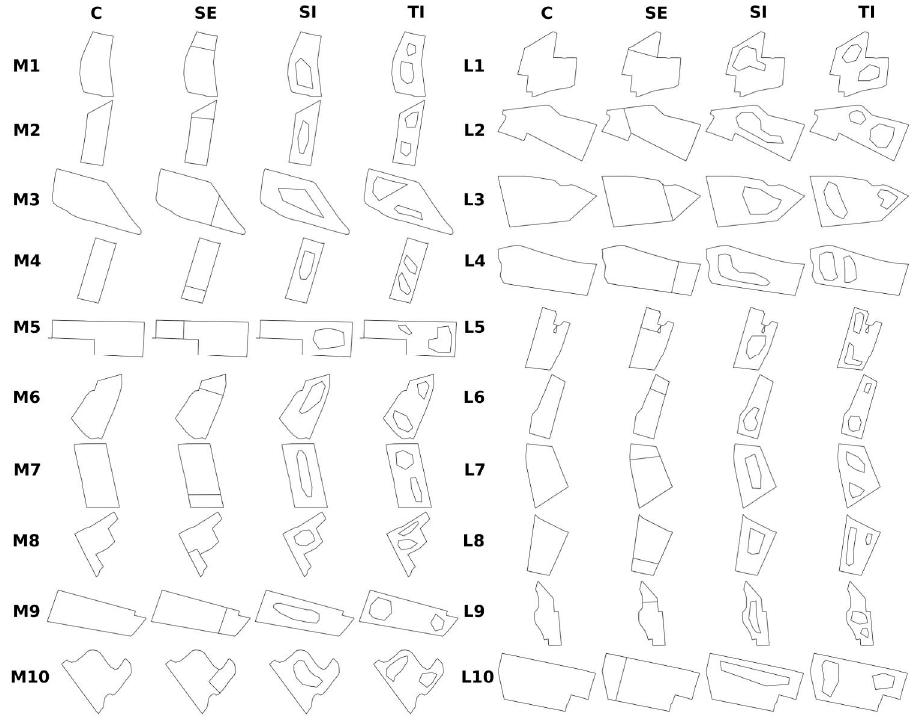
Figure 3. Overview of the set of fields and their distinct harvest cases.